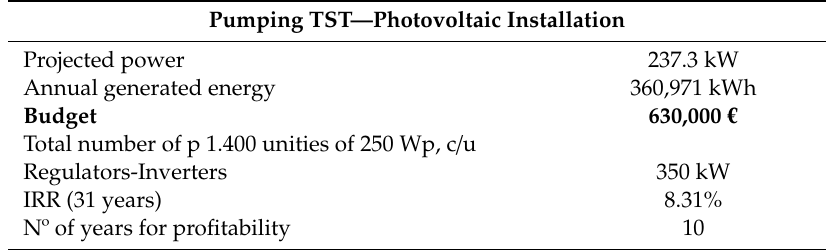
Table 7. Summary of the photovoltaic solar installation of the Tajo-Segura transfer pumping.